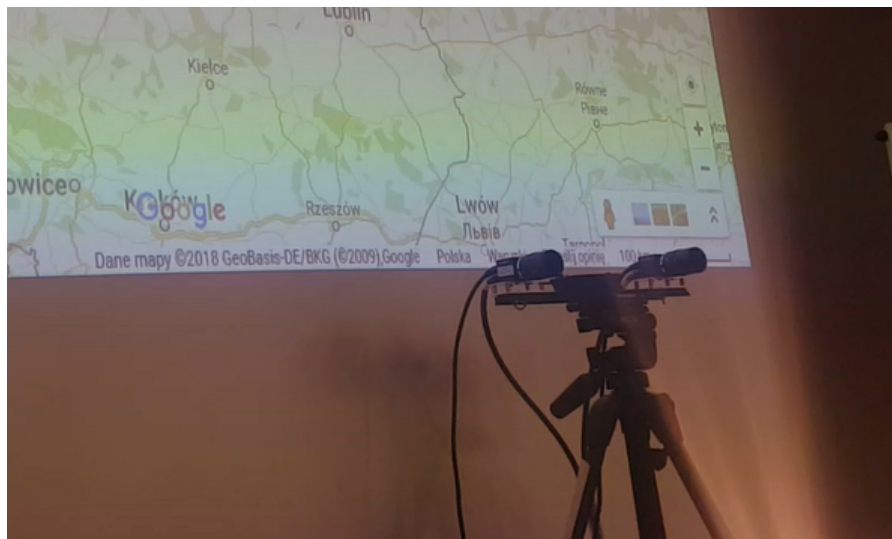
Figure 37. The camera arrangement in front of the presentation